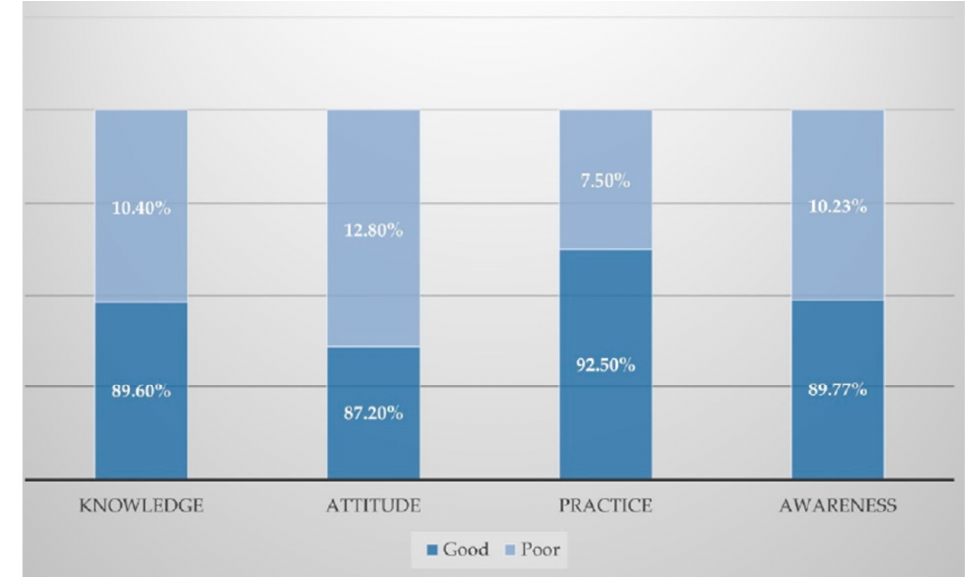
Figure 1. Awareness and overall KAP levels regarding the COVID-19 pandemic in Saudi Arabia.